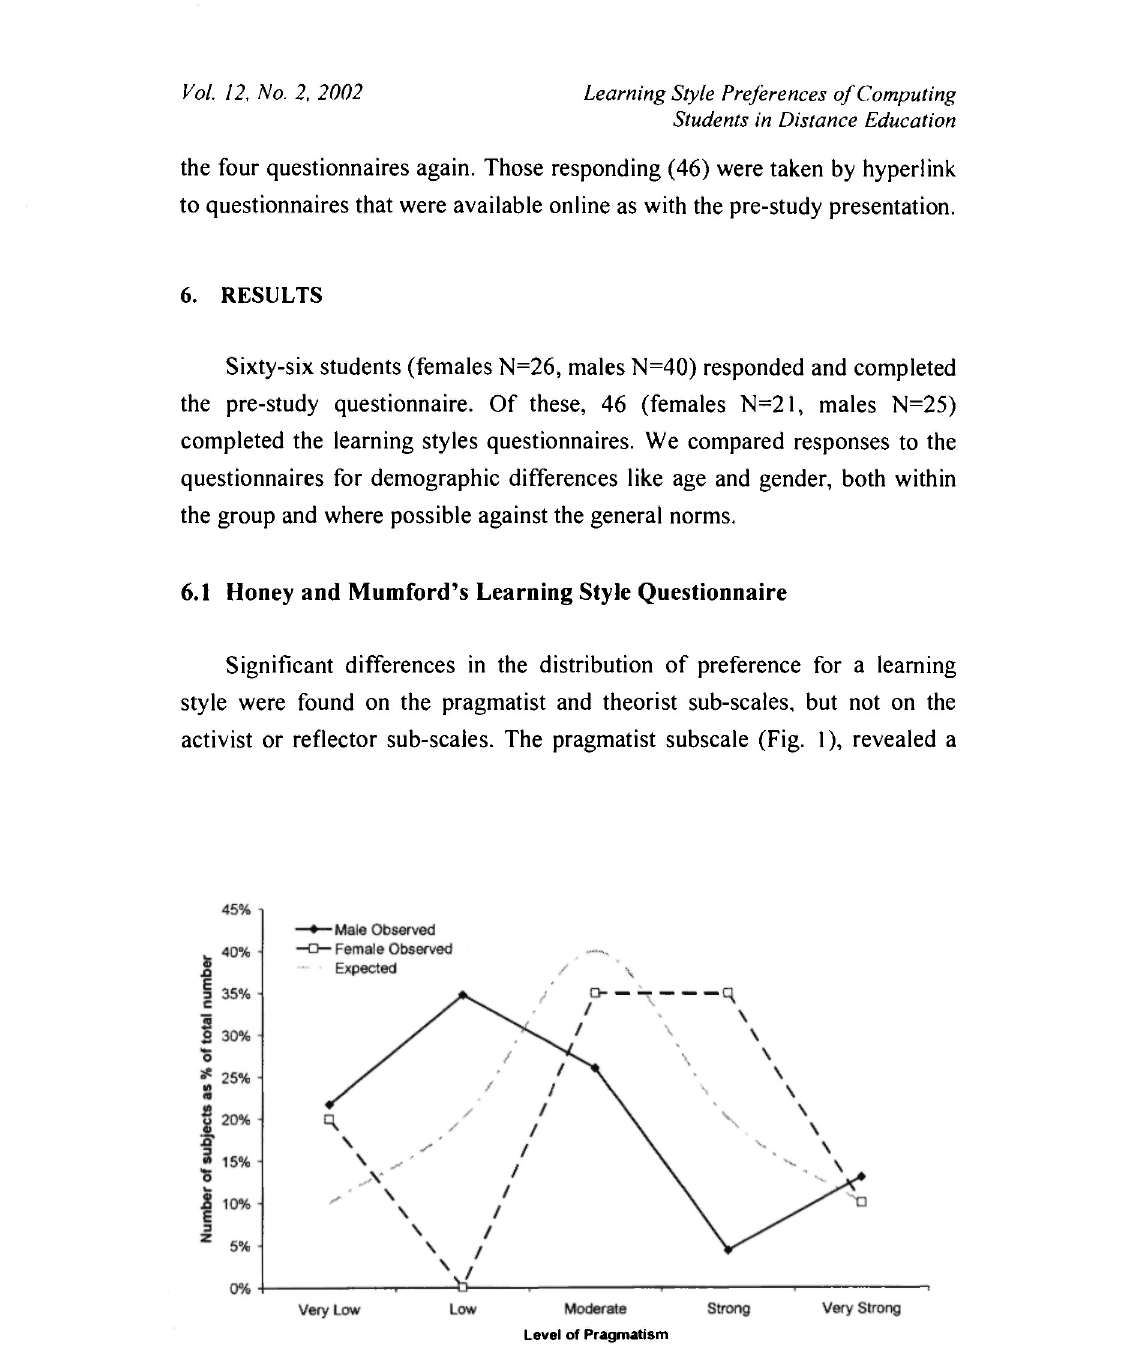
Fig. 1: Frequency distribution of preferences on the Pragmatist